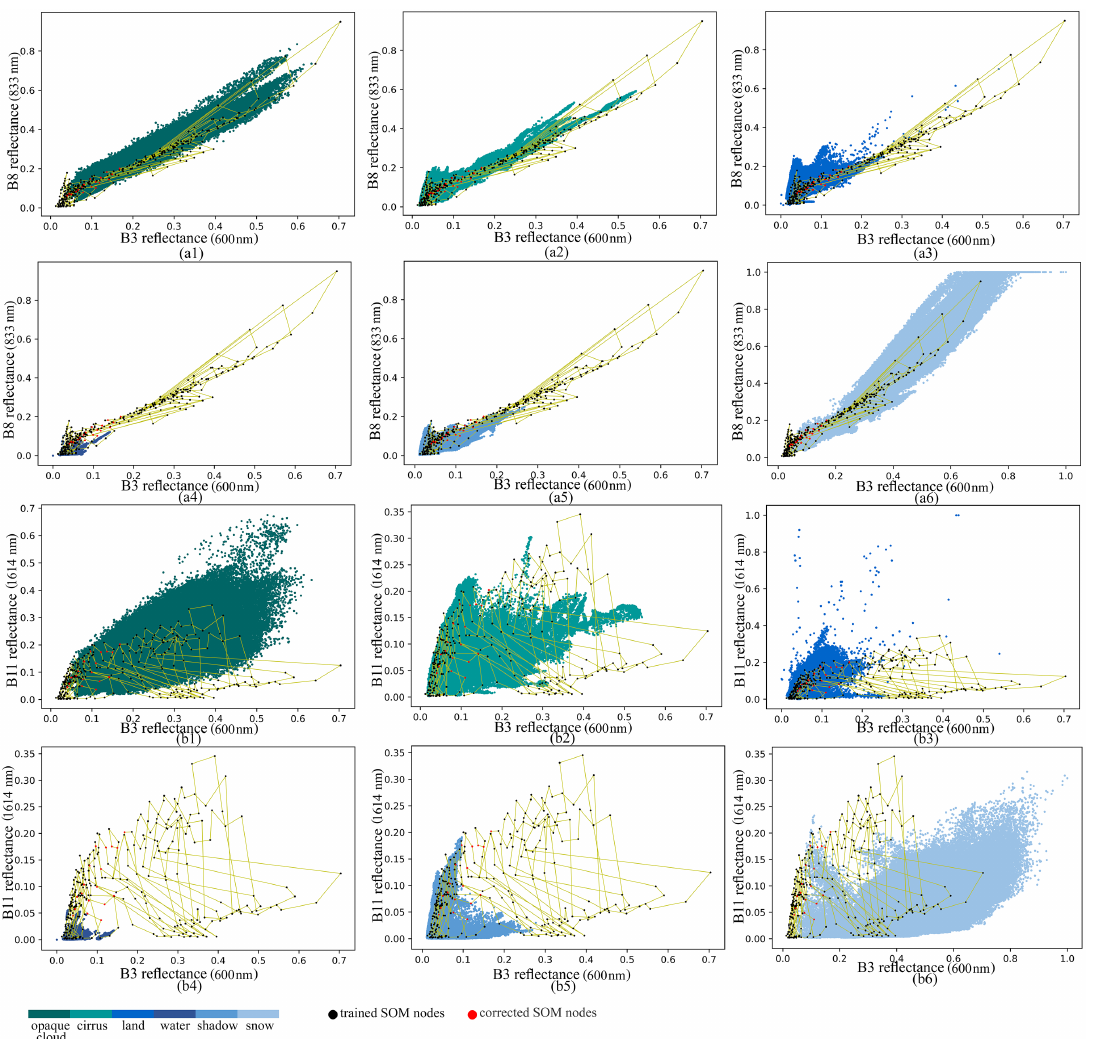
Figure 8. Separate scatterplots of the six classes of the training